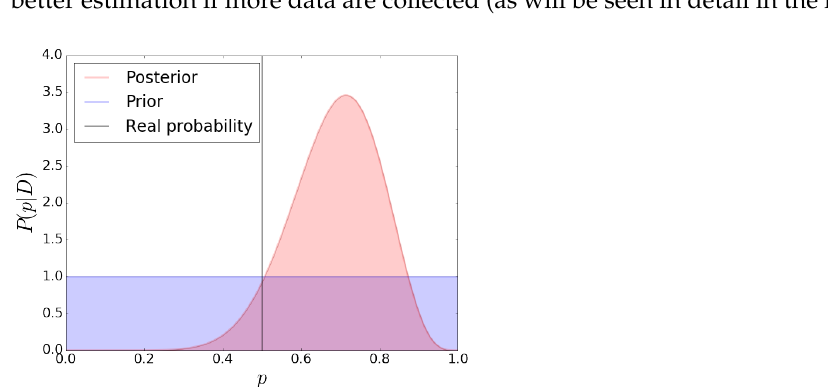
Figure 1. The coin example: blue figure displays the prior distribution P ( p ) which is updated, when the data is taken into account, to get the posterior distribution P ( p corresponds to the real value, p =